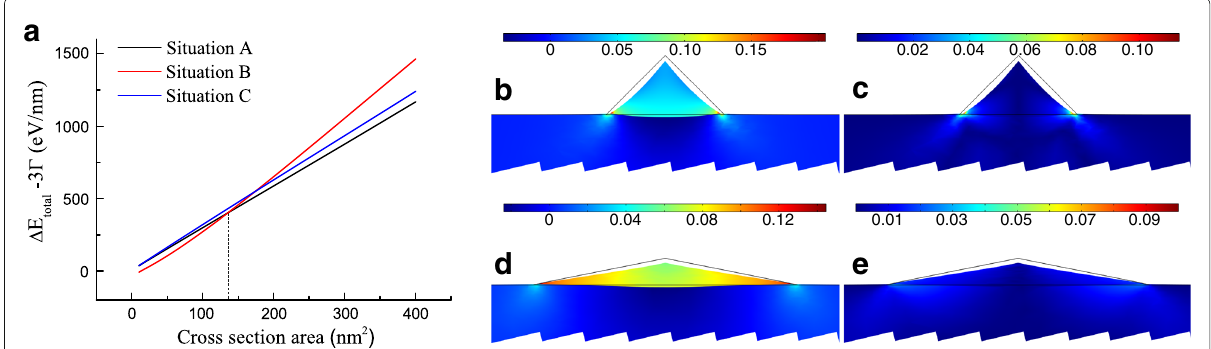
Fig. 3 a The total energy change excluding the edge energy change 3 (cid:2) vs. the cross section area (the dashline is the critical value of minima about 136.2 nm 2 in different situations). b – e hydrostatic strain and | ε xy | + | ε yz | + | ε xz | in b , c situation A and d , e situation B at the critical value